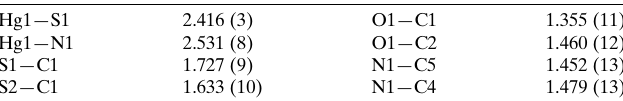
Table 1 Selected bond lengths (A˚ ).